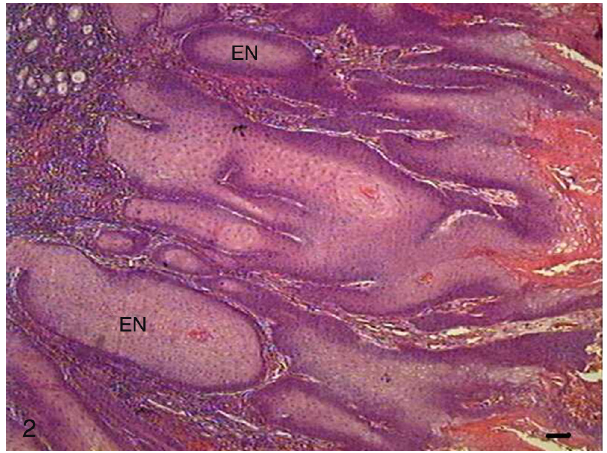
Figure 2 Grade I squamous cell carcinoma. Micrograph of grade I squamous cells, with invasion of connective tissue by tumor cells in the form of very delimited epithelial nests (EN) (HE, bar = 100 (cid:2)